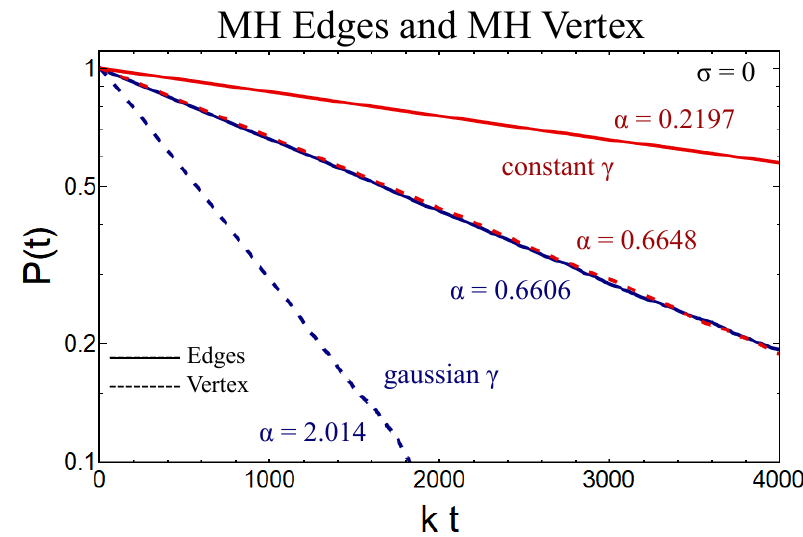
Figure 7. (Color online) Polarization functions in the MH model with the zero disorder parameter, σ , for two different models of the local field magnitudes, γ : constant magnitudes (red) and Gaussian magnitudes (blue). Solid lines use the edges version, while dashed lines use the vertex version. The spin relaxation rate fit constants, α , are given for each (see Equation (24)). Additional parameters used in the simulations are γ = 0.025 (for the Gaussian approximation, γ is the width of the distribution) and k =